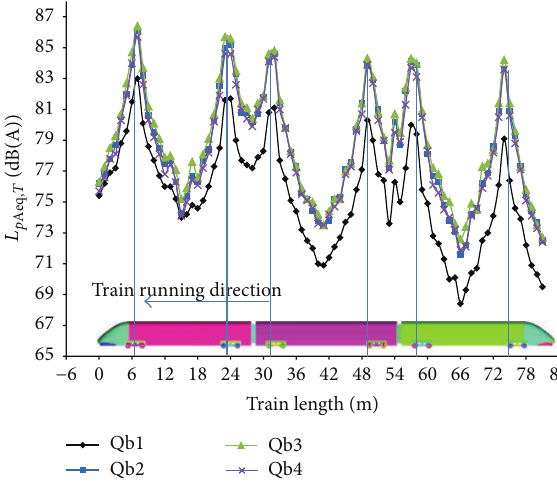
Figure 33: Comparison of the longitudinal SPL distributions for high-speed trains with different bogie skirt board designs.